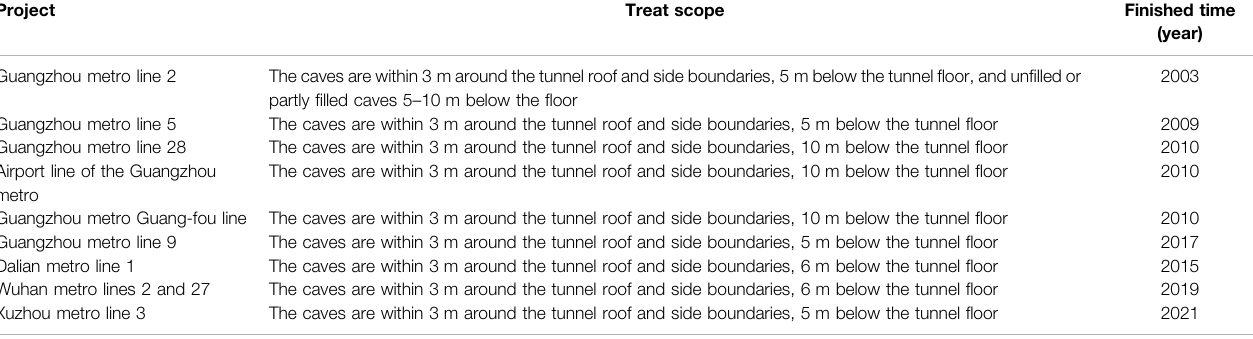
TABLE 4 | Cases of pretreatment from the ground surface. Project